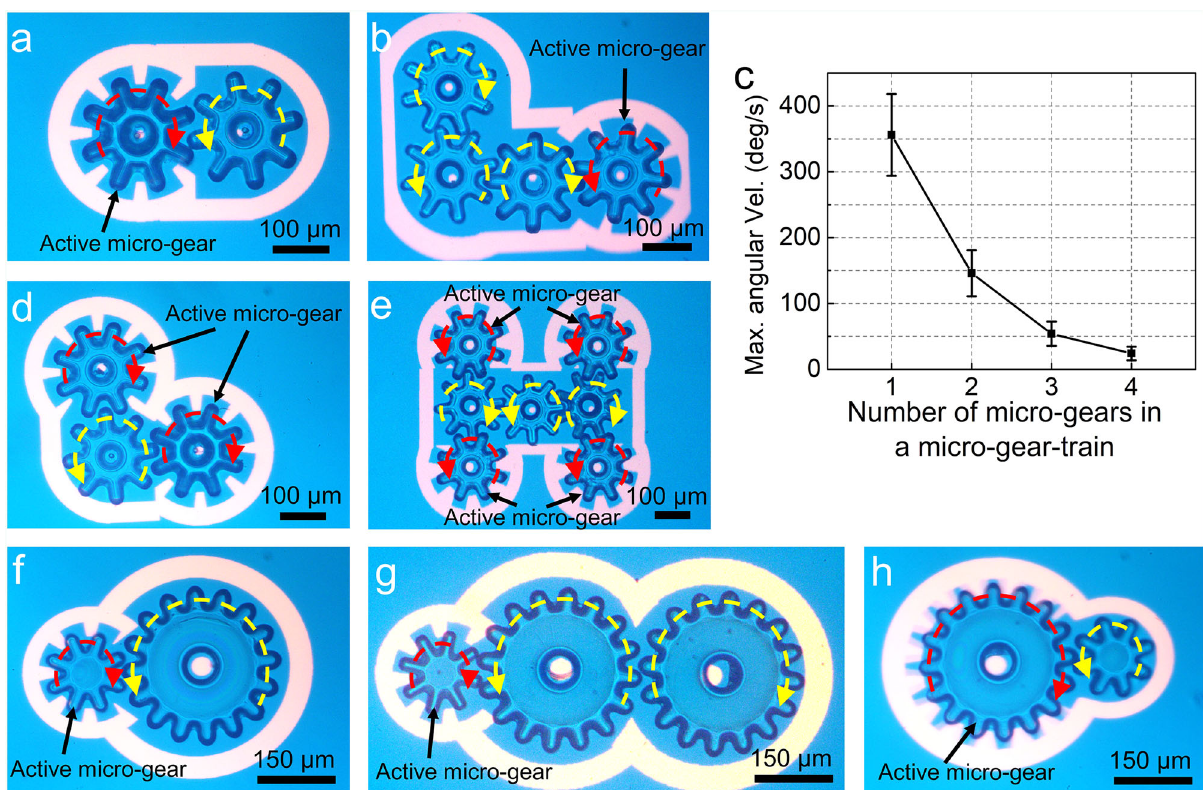
Fig. 5 Micromachine 2: the micro-gear train. Frames from Supplementary Movie 12 illustrating micro-gear-trains driven by one active micro-gear comprising a two and b four micro-gears. c Plot of maximum angular velocity as a function of the number of components in a micro-gear-trains with one active micro-gear driven by a 20 V pp OET bias voltage at 10 kHz. Error bars represent ±1 SD from fi ve measurements for each type of micro-gear-train (assembled from different components). Frames from Supplementary Movie 13 illustrating micro-gear-trains driven by d two active micro-gears (three total) and e four active micro-gears (seven total). f – h Frames from Supplementary Movie 14 illustrating micro-gear-trains formed from small (150 μ m diameter) and large micro-gears (300 μ m diameter). In ( f , g ), the small micro-gear drives the system; in ( h ), the large micro-gear drives the system. In all images, red and yellow dashed lines with arrowheads represent the rotation directions of the active and passive micro-gears,